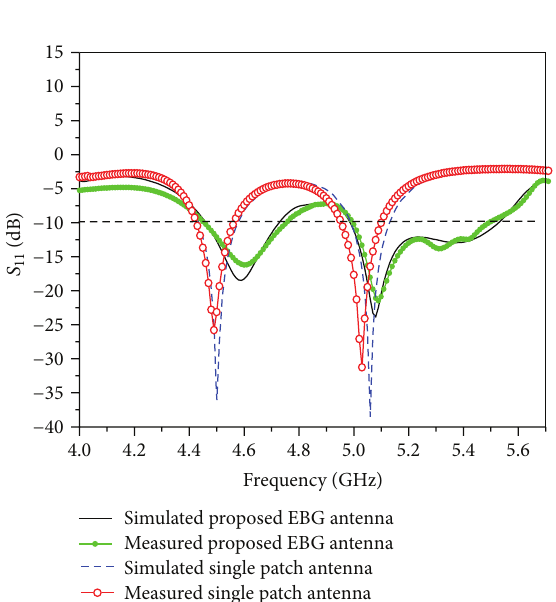
Figure 11: Simulated and measured 𝑆 11 of single antenna and proposed EBG antenna.